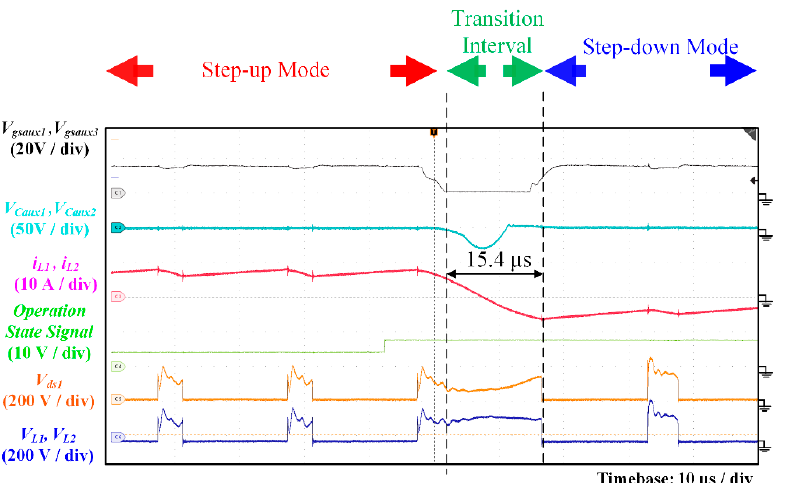
Figure 19. Experimental waveforms of transition from step-up mode to step-down mode with a half-load condition.